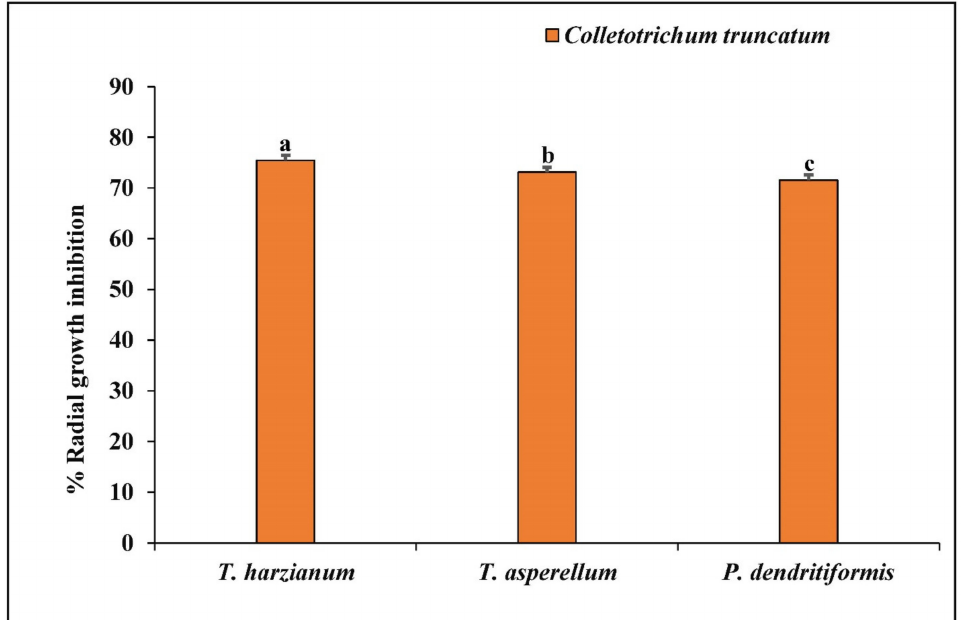
Figure 5. Effects of T. harzianum , T. asperellum, and P. dendritiformis on the inhibition of hyphal growth of C. truncatum . Each value is expressed as the mean of triplicates, and the bars sharing the same alphabetical letters are not significantly different ( p ≤ 0.05) using Duncan’s multiple range test. The vertical bar designates the standard